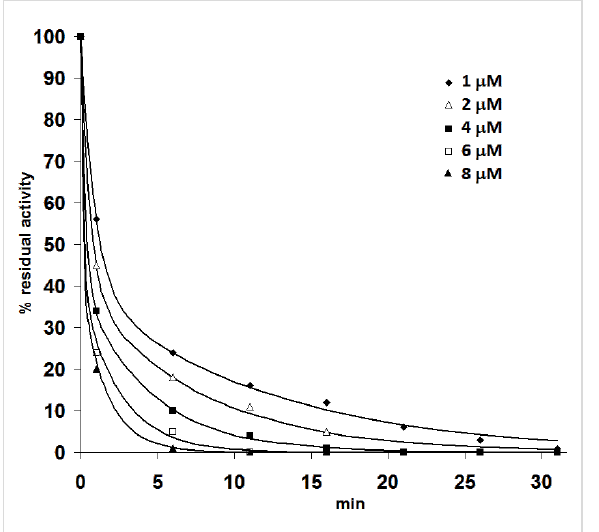
Figure 2: Time course inactivation of Zm PDC by various concentra- tions of furan 17 .